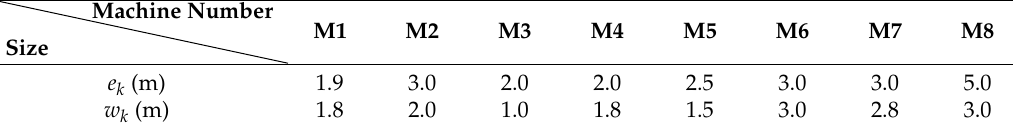
Table 4. The size of each machine.